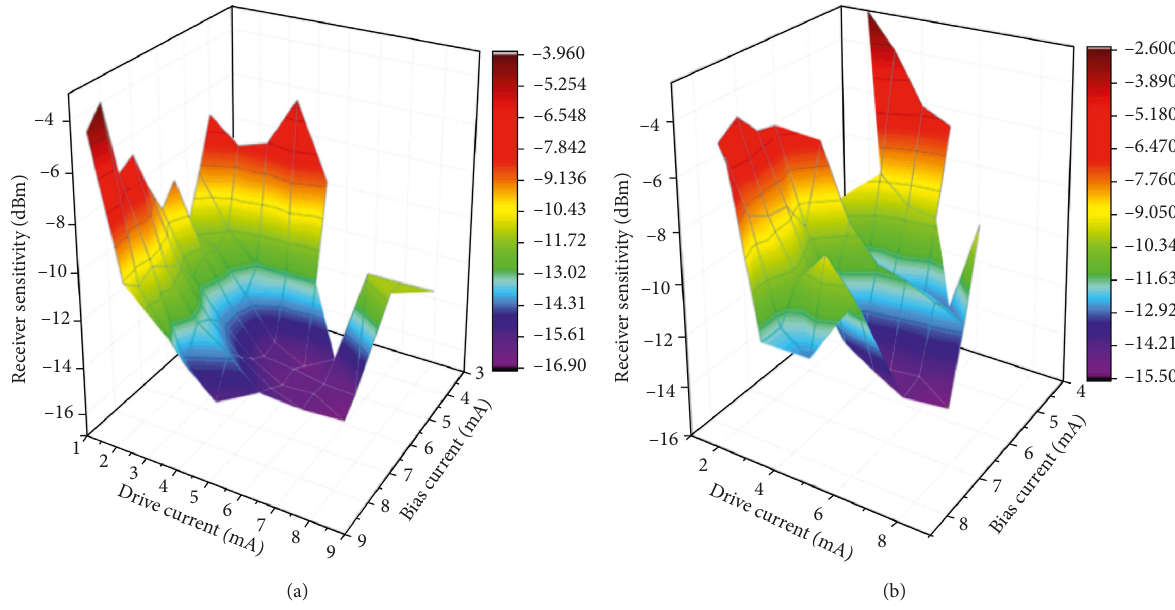
Figure 6: Receiver sensitivity for the VCSEL at different bias and drive currents: (a) back-to-back analysis [33] and (b) 25km transmission.